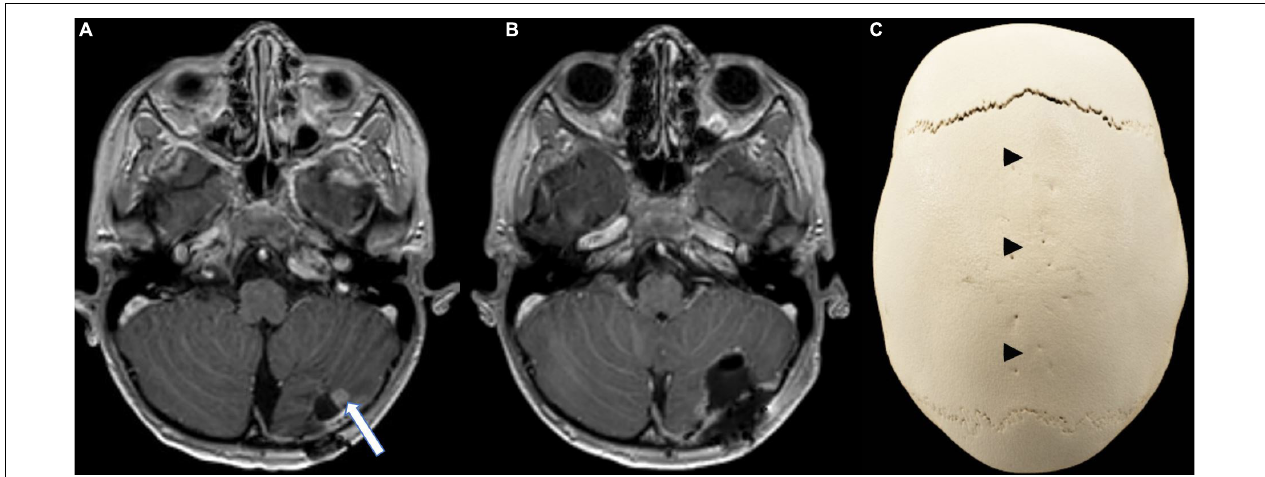
FIGURE 3 | Follow-up imaging. (A) Axial contrast-enhanced T1-weighted MR image showing a contrast enhancing nodule (arrow) at the infero-lateral border of the resection cavity, strongly suggestive of local recurrence. (B) Axial contrast-enhanced T1-weighted MR image after en-bloc resection of the recurrent tumor. (C) CT reconstruction (Volume rendering) of the skull highlighting the dolichocephaly and the premature synostosis of the sagittal suture (arrow heads) when compared to the open